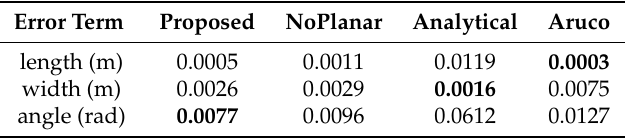
Figure 11. Robot extrinsic calibration precision test setup and results. ∗ denotes the mean of [ t x , t y ] T , the ellipse indicates covariance at 95% confidence, and the dotted rectangle is the nominal rectangle. Table 1. Rectangle errors of the four different methods. The bold number indicates that the error is minimum.